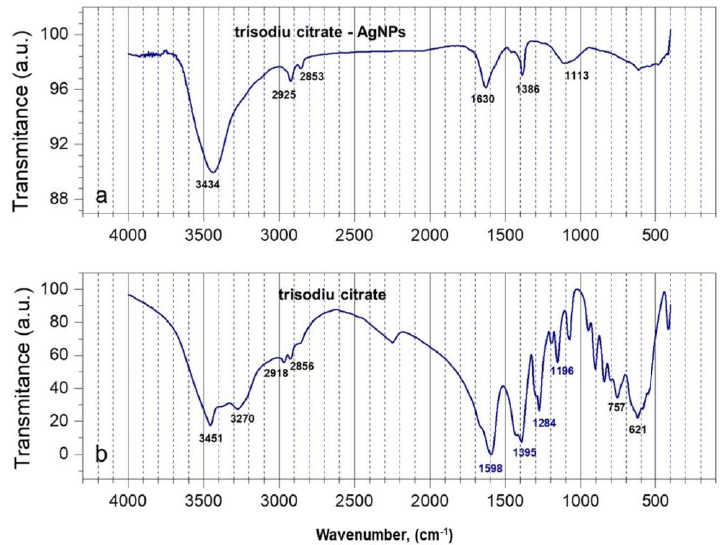
Figure 4. FTIR spectra of sodium-citrate-coated silver nanoparticles ( a ) and sodium citrate ( b ).